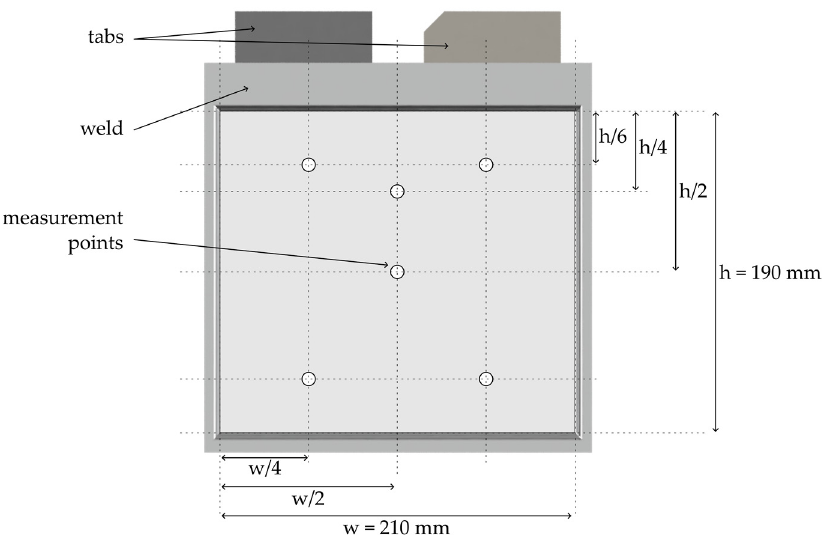
Figure 3. Locations of temperature measurement points.